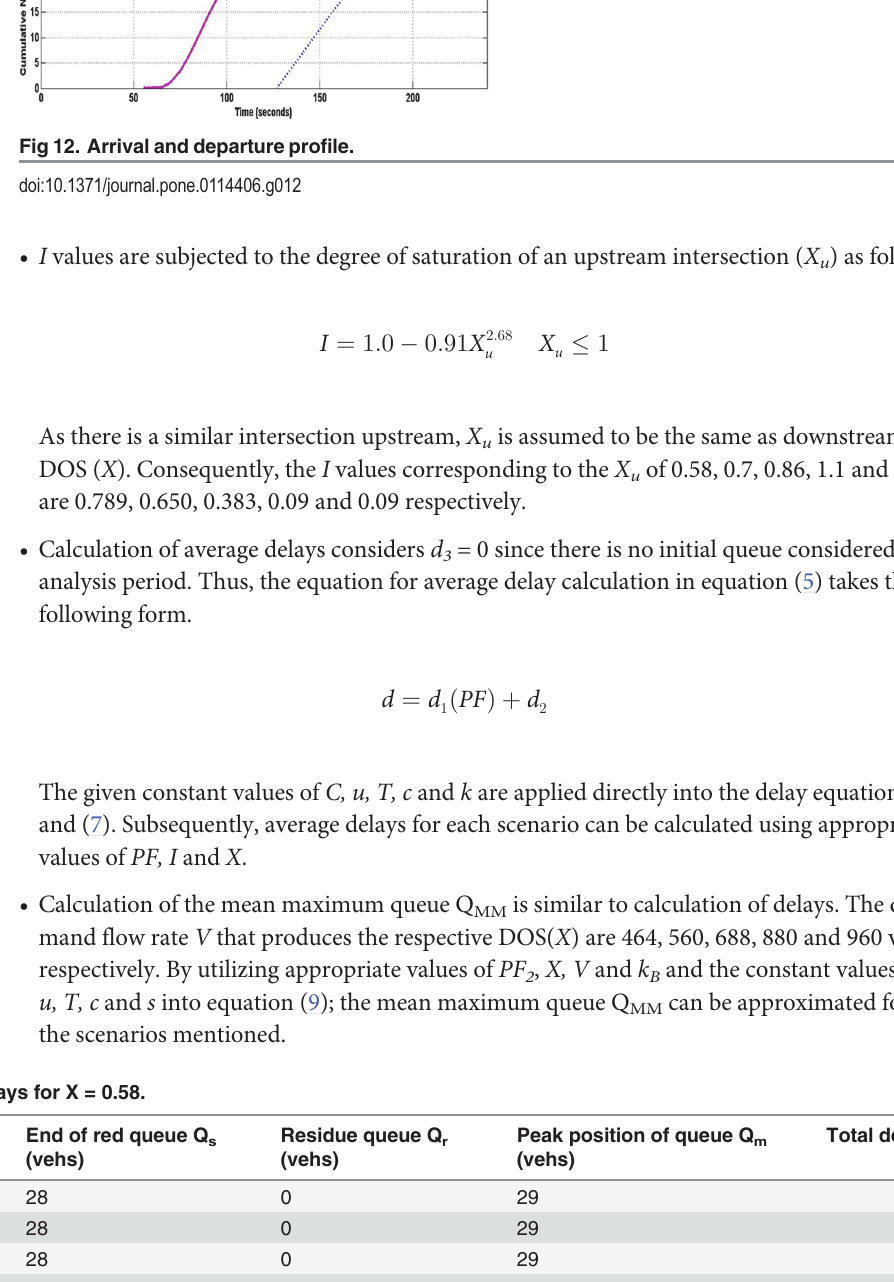
Residue queue Q r (vehs)